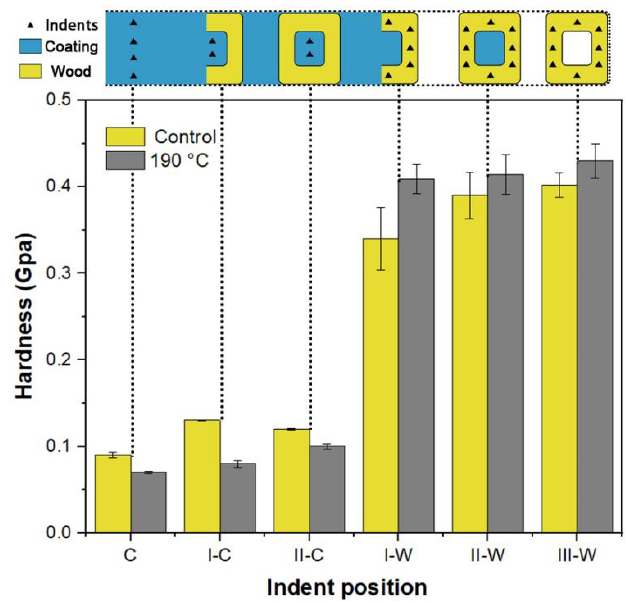
ff erent locations at the sample